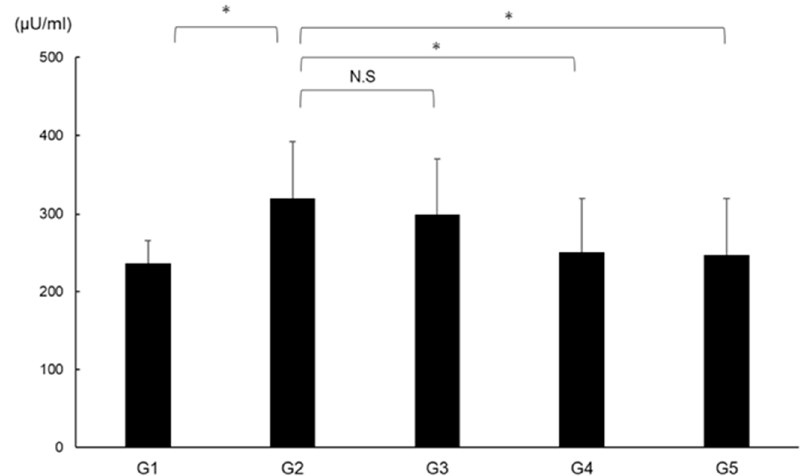
Figure 11. E ff ects of canagliflozin (CA) and teneligliptin (TE) on serum DPP4 activity. G1, Group 1